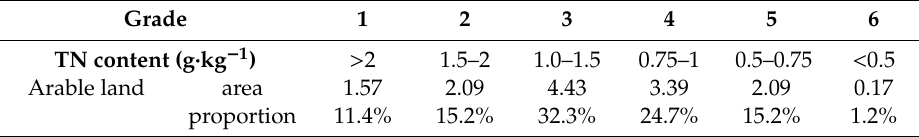
Table 3. Soil TN grades, with corresponding areas (10 10 km 2 ) and